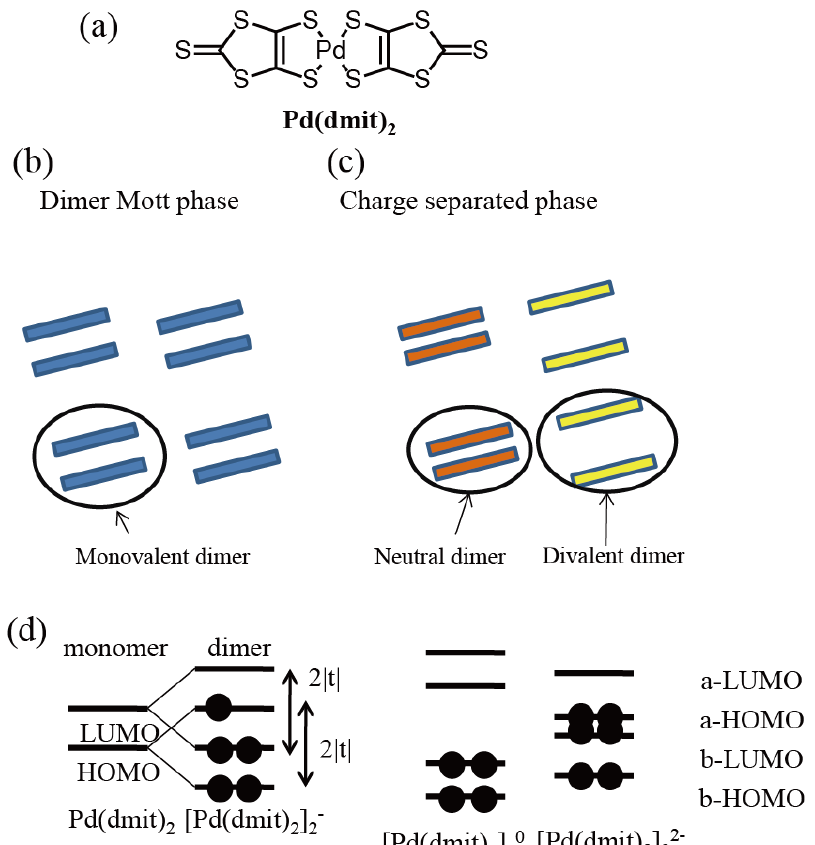
Figure 2. ( a ) Molecular structure of Pd(dmit) high-temperature dimer Mott insulating phase of Et ( c ) Schematic of crystal structure of low-temperature charge-separated phase on Pd(dmit) plane. Rectangles in ( b ) and ( c ) represent Pd(dmit) long axis and are colored corresponding to valences of dimers; ( d ) Schematic energy diagram of Pd(dmit) monomer and dimers. Closed circles represent 2